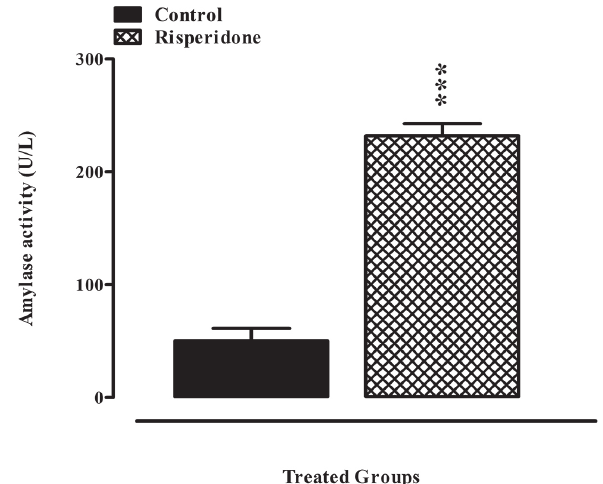
FIGURE 3 - Effect of Risperidone (2.5 mg/kg/d) on amylase: Three weeks oral treatment of rats exhibited significant increase in amylase level (U/L) in risperidone treated group as compared to control (***P<0.001) (unpaired